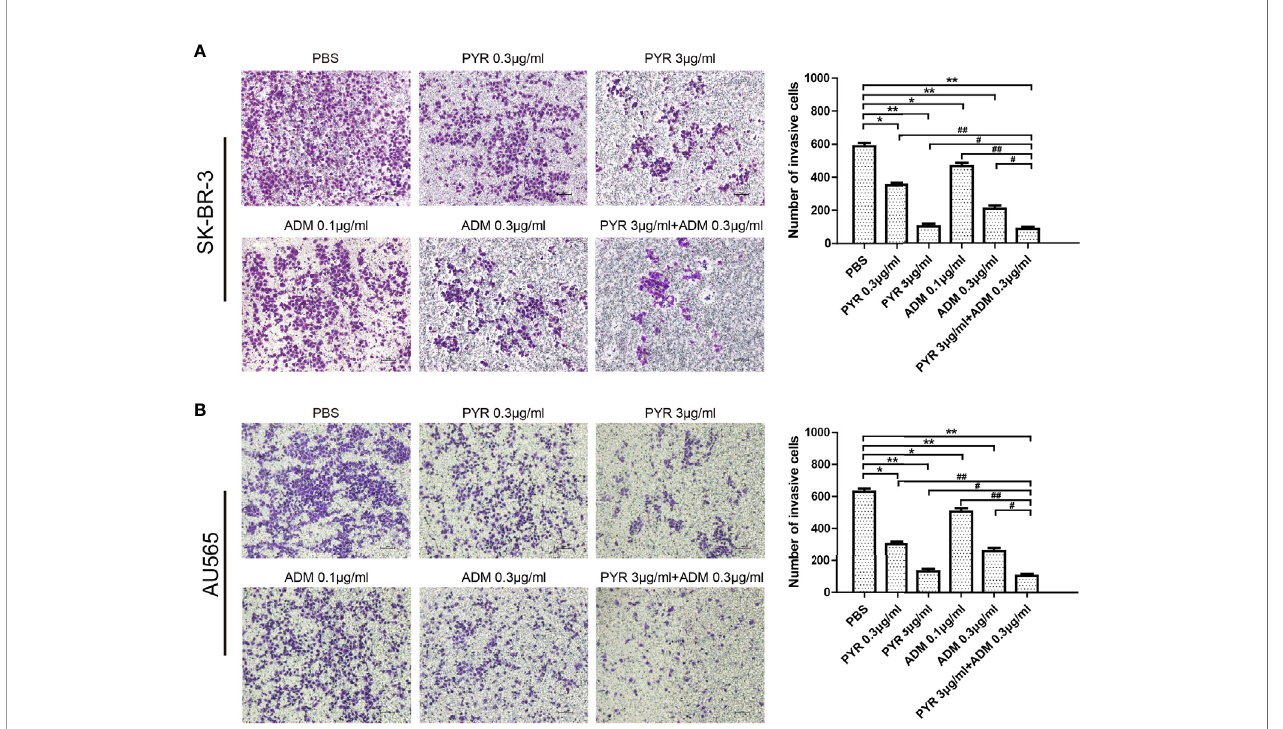
FIGURE 3 | Effects of PYR and ADM on cell invasion. Cell invasion was analyzed with a Matrigel-coated Boyden chamber. SK-BR-3 and AU565 cells were treated with PBS, different concentrations of PYR (0.3, 3 m g/ml), ADM (0.1, 0.3 m g/ml) or a combination treatment(PYR+ADM) for 24 h. (A) Transwell invasion assays assessed the effect of PYR and ADM on SK-BR-3 cell invasion ability and histogram represents the statistical analysis. (B) Transwell invasion assays assessed the effect of PYR and ADM on AU565 cell invasion ability and histogram represents the statistical analysis. Original magni fi cation was ×100. Data represent the mean ± S.D. of three independent experiments. *p<0.05 and **p<0.01 compared with the PBS group, # p<0.05 and ## p<0.01 compared with the combination